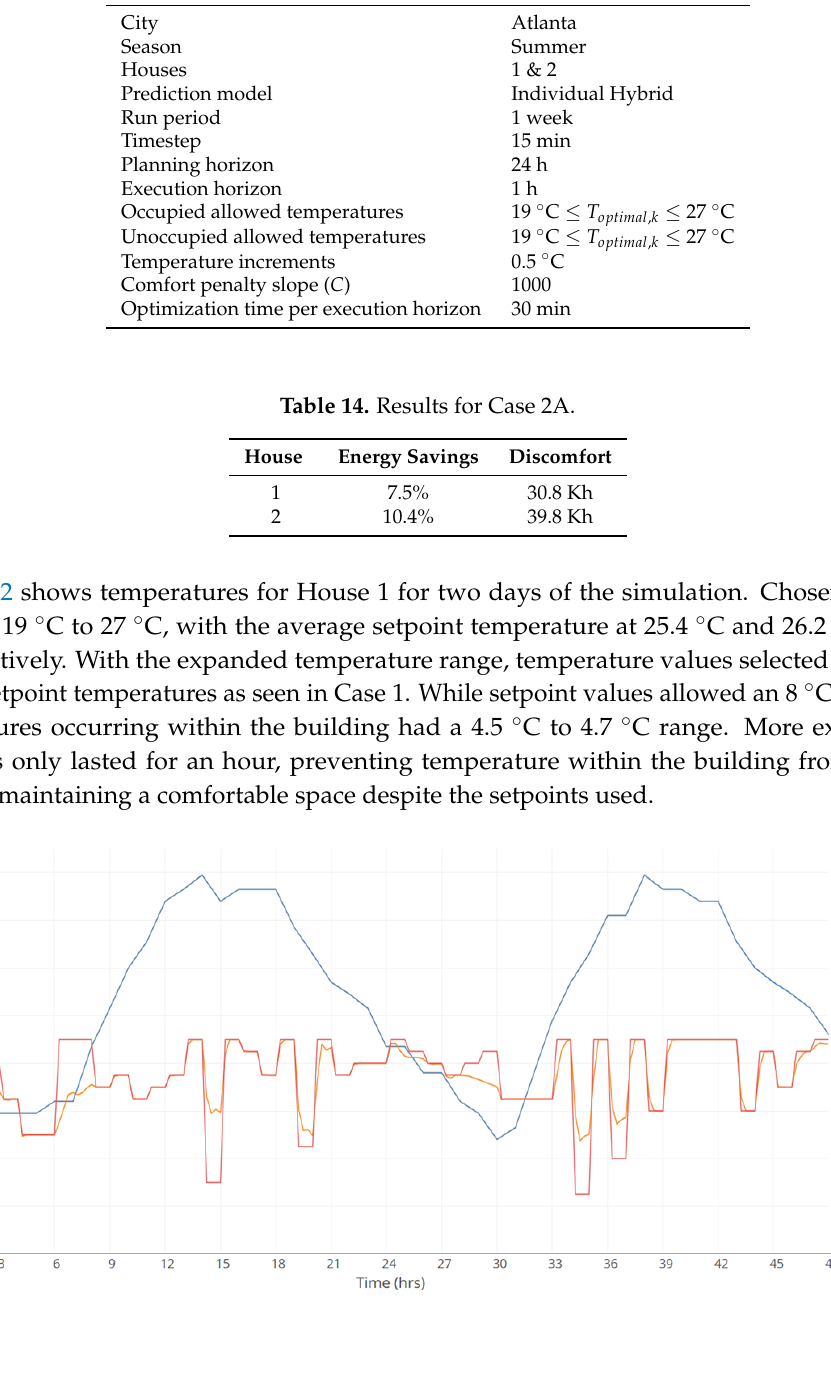
Figure 12. Case 2A temperatures for House 1 using individualized hybrid prediction